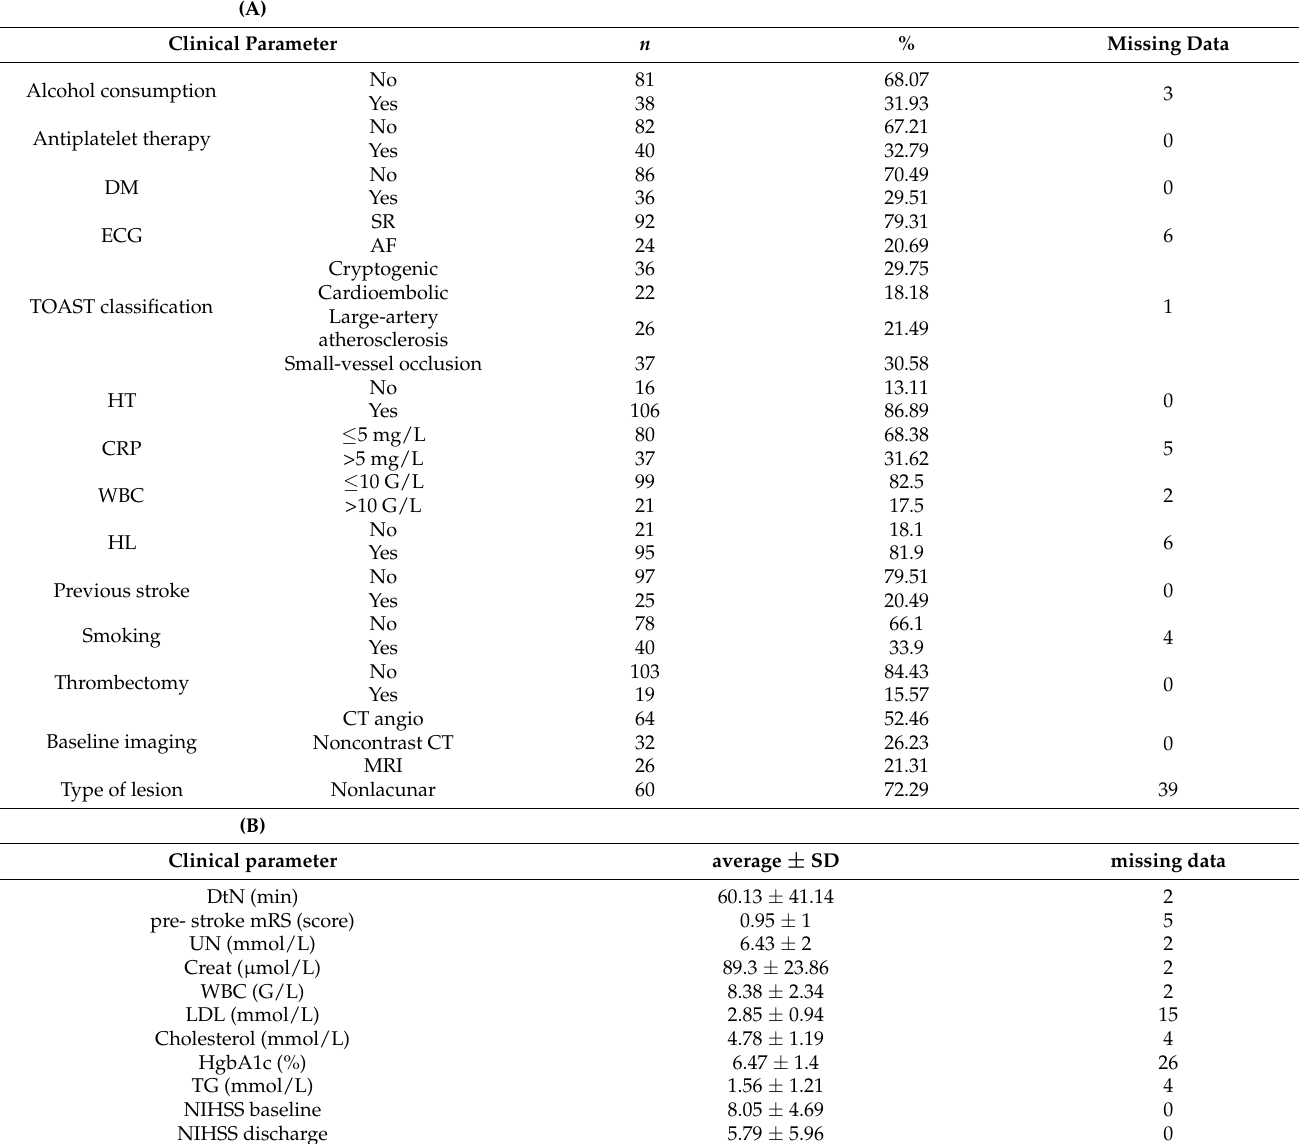
Table 2. Categorical (Table 2/ A ) and continuous (Table 2/ B ) clinical parameters of ischemic stroke patients involved in the